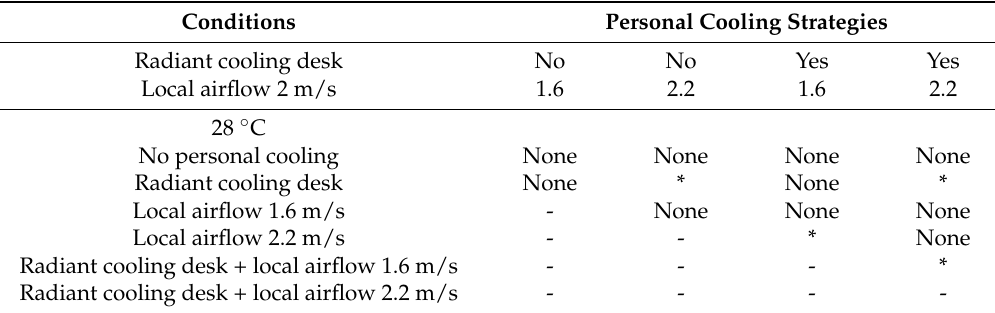
Table 7. Thermal comfort differences among personal cooling systems.